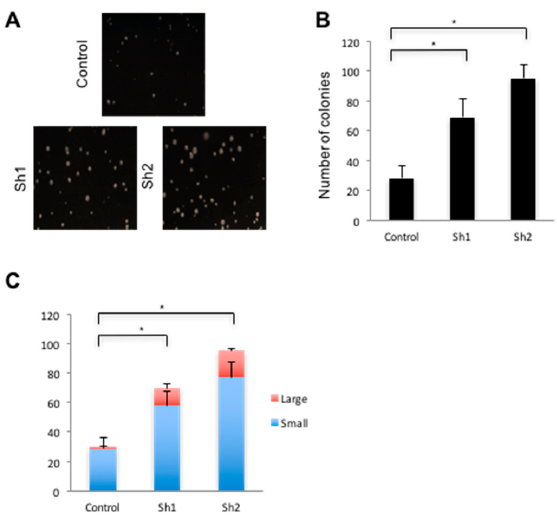
Figure 6. Cdx2 knockdown leads to increased anchorage-independent growth. ( A ) Colonies grown in soft agar from control and Cdx2 Sh knockdowns SW480 cells. ( B ) Quantification of number of colonies in soft agar and ( C ) Size distribution of SW480 colonies formed in soft agar. Error bars represent the standard deviation of five fields of view from three independent samples. * p < 0.05 by Student’s t